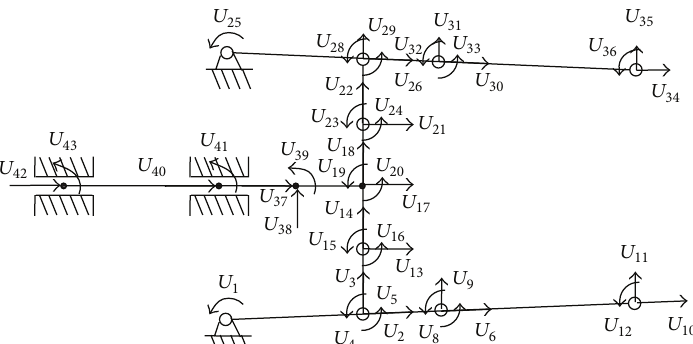
Figure 7: The finite element model of the clamping